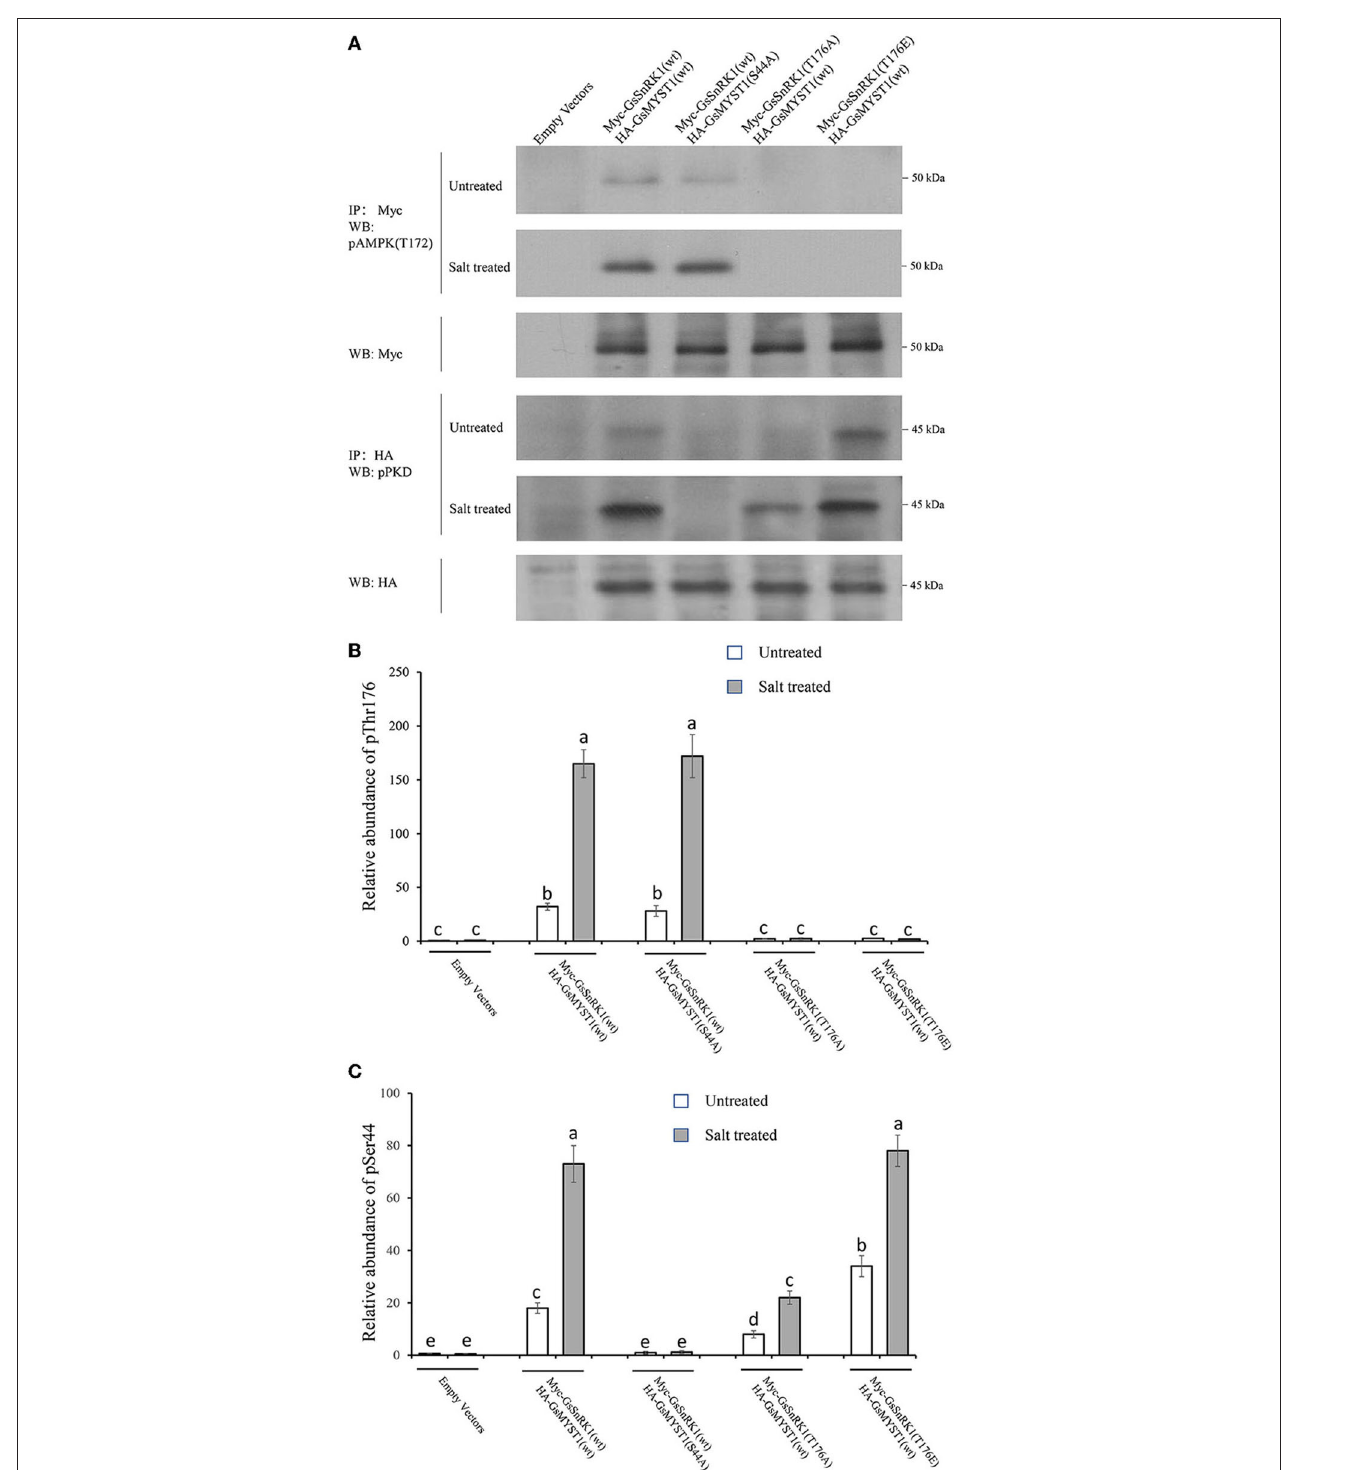
FIGURE 5 | In vivo GsMYST1 phosphorylation assays. (A) The indicated plasmids were cotransformed into soybean hairy roots mediated by Agrobacterium rhizogenes . The total proteins were extracted from the roots after the plants were treated with 150mM NaCl for 2h. Myc-GsSnRK1 or HA-GsMYST1 were immunoprecipitated from total proteins using mouse anti-Myc or anti-HA antibodies. The immunoprecipitated proteins were resolved in SDS-PAGE gels for WB using the indicated antibodies. (B) The relative phosphorylation levels of Thr176 in GsSnRK1 before and after salt treatment. (C) The relative phosphorylation levels of Ser44 in GsMYST1 before and after salt treatment. Bars indicate SE, the t-test, and the columns were shown from three biological triplicates ( t -test, p < 0.05, expressed in different small letter alphabets).